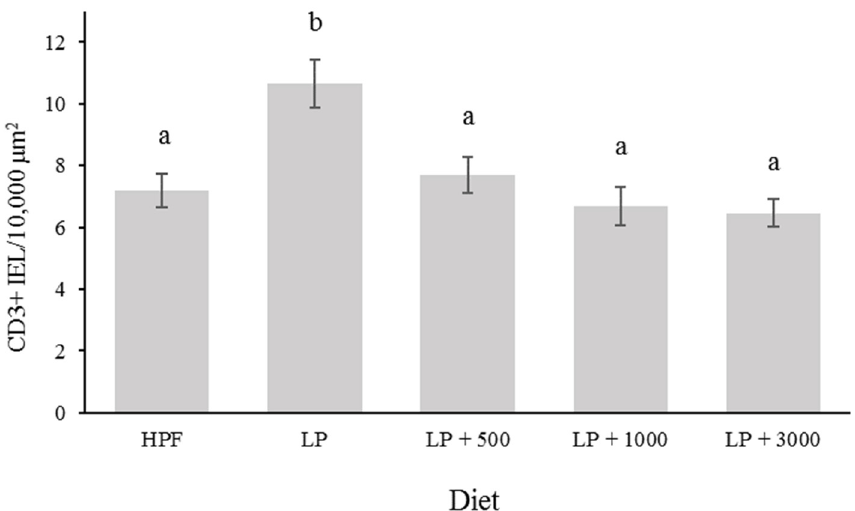
Figure 1. Effect of different inclusion levels of phytase on CD3-positive intraepithelial lymphocytes in cecum of broiler chickens at 21 days of age ( p < 0.001); HPF: hypoallergenic phytate-free diet; LP: low-phosphorus diet; LP + 500: low-phosphorus diet + 500 FTU/kg feed; LP + 1000: low-phosphorus